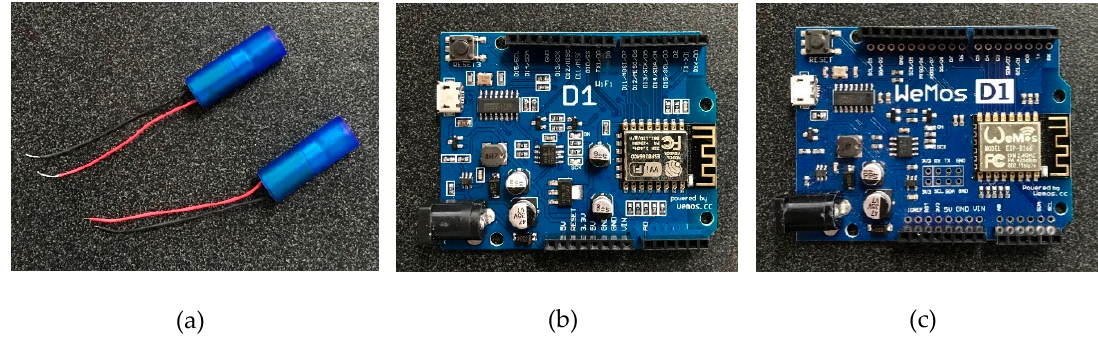
Figure 2. System components: ( a ) Vibration motors; ( b ) server; ( c ) client.